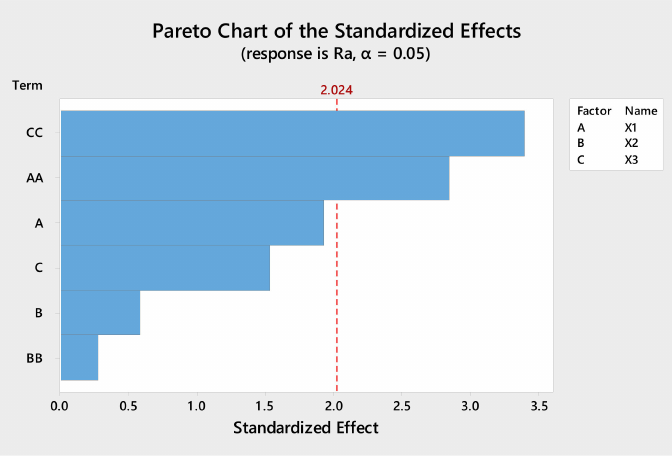
Figure 3. Pareto chart of the e ff ects of investigated parameters on surface roughness R a